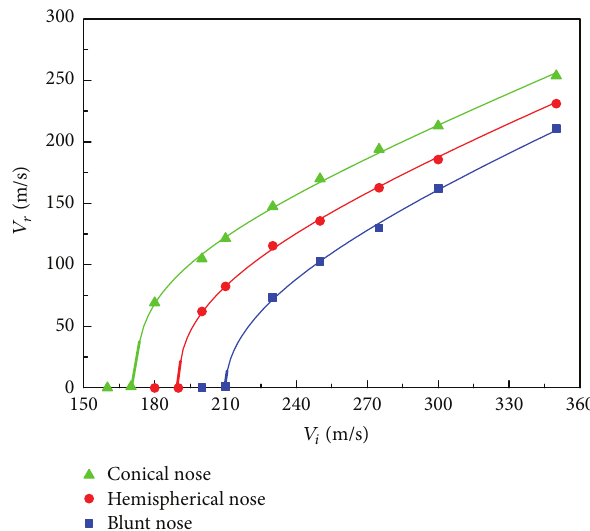
Figure 23: Residual velocity versus impact velocity of projectiles for auxetic HSPs with three types of nose